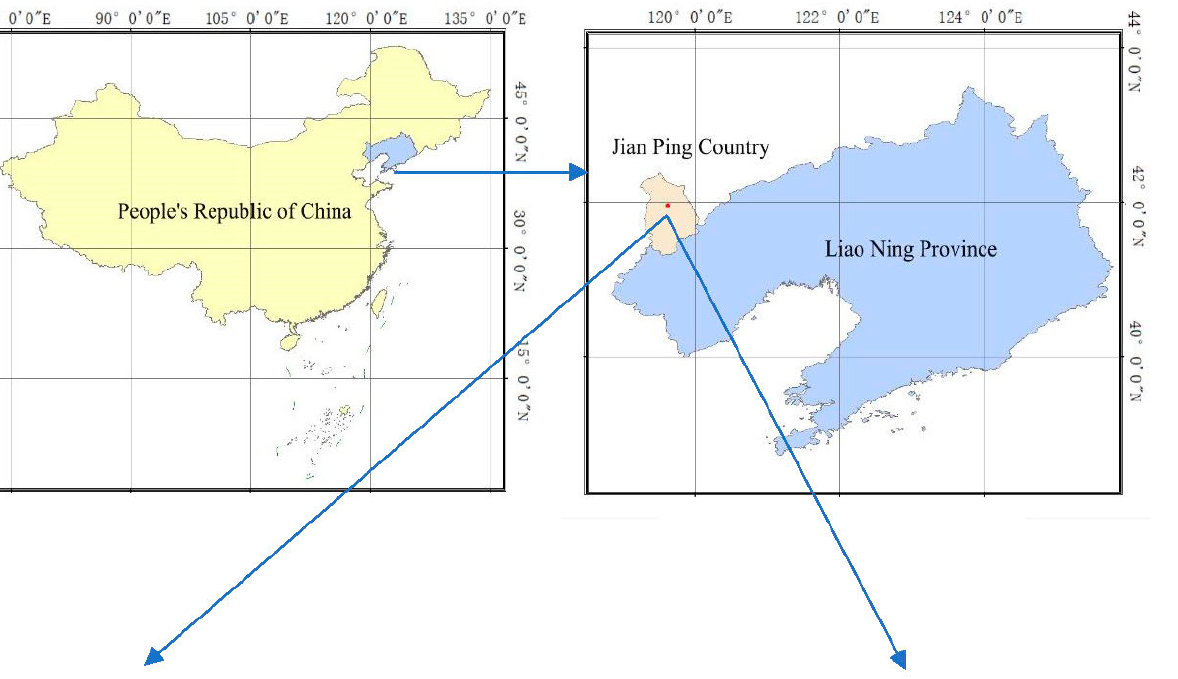
Figure 1. Site location, land uses, and sampling points (dots) of studied watershed. 2.2. Sample Collection and Preparation Topsoil (0–10 cm) that were removable by erosion were collected with a triplication at each upper, middle and bottom position of the slope lands from each land use (cropland, forest, grassland and gully) in September 2018. At each sampling point as shown in Figure 1, three replicates of soil samples were randomly collected. A total of 165 soil samples were collected from each land use representing cropland (19 × 3), forest (14 ×